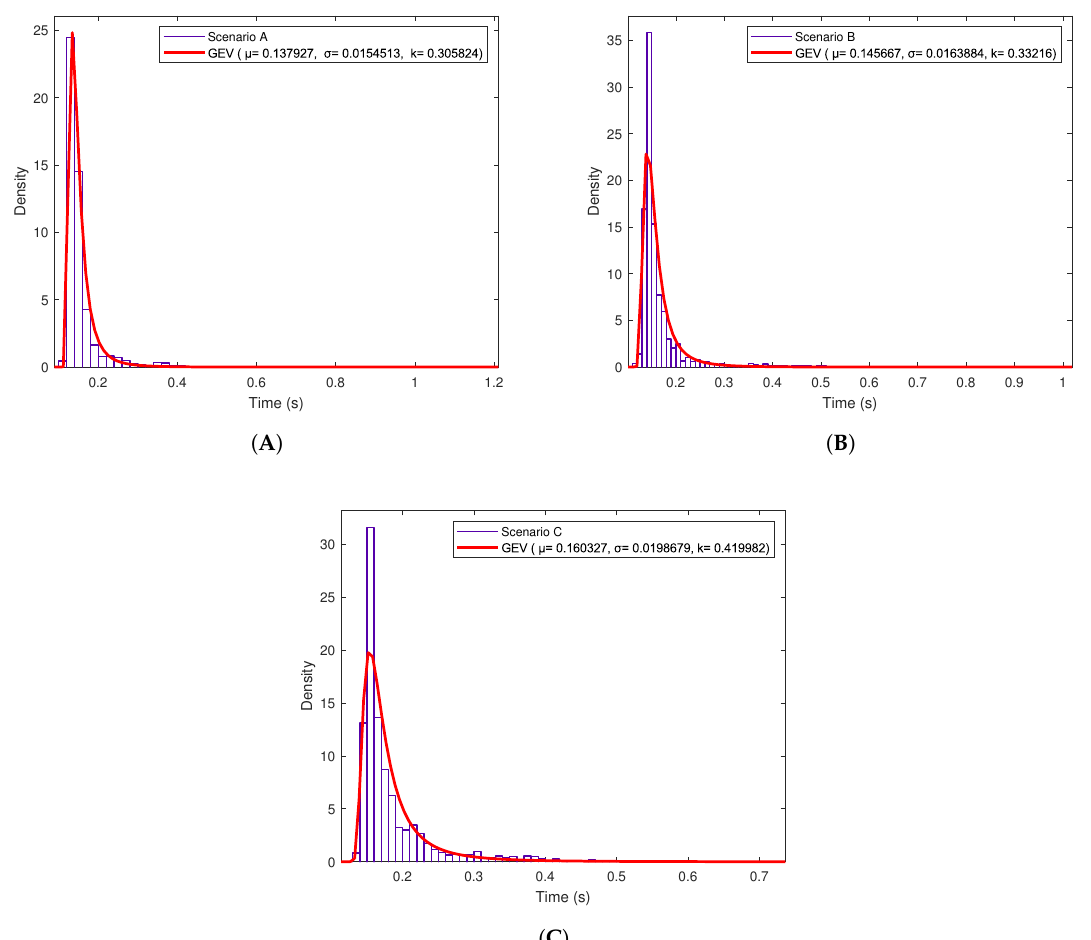
Figure 15. Probability Density Function (pdf) in OrbitDB for ( A ) Scenario A, ( B ) Scenario B and ( C ) Scenario C.